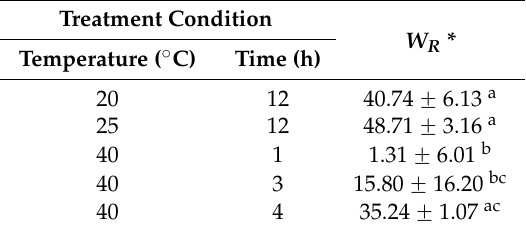
Table 1. Average weight reduction rates ( W R ) (% (mean ˘ SD)) for the 5 treatments ( n = 5).